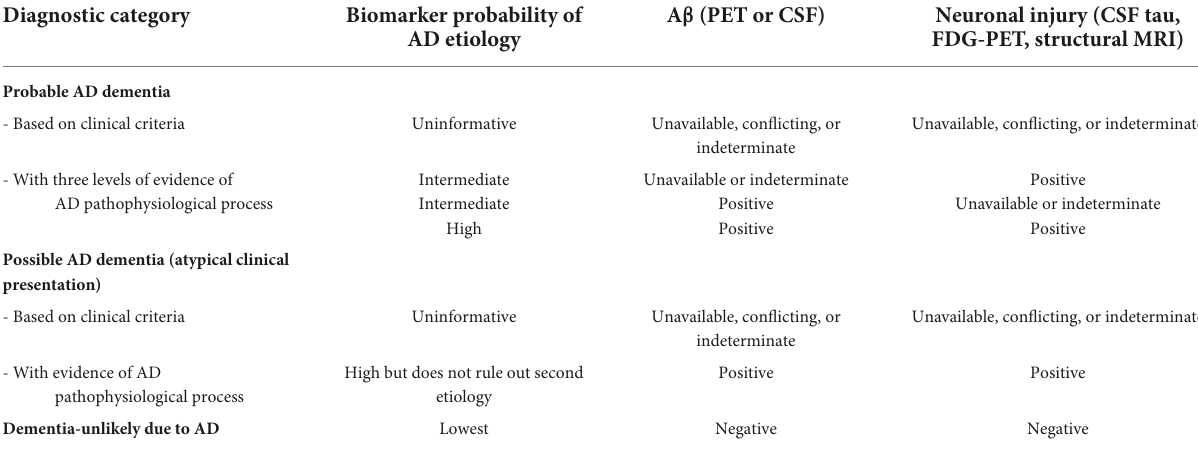
TABLE 2 Criteria for an Alzheimer’s disease (AD) diagnosis including